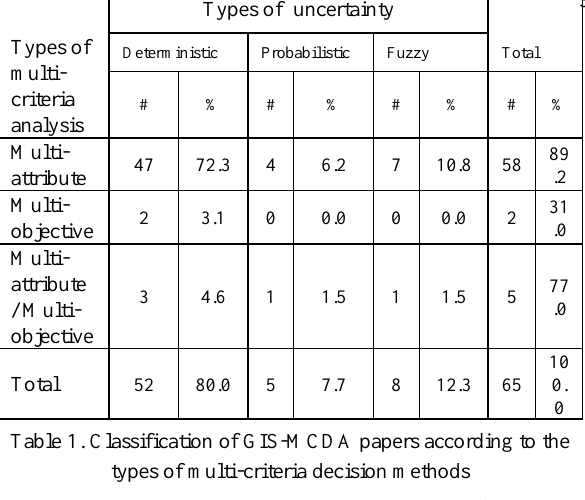
Table 1. Classification of GIS-MCDA papers according to the types of multi-criteria decision